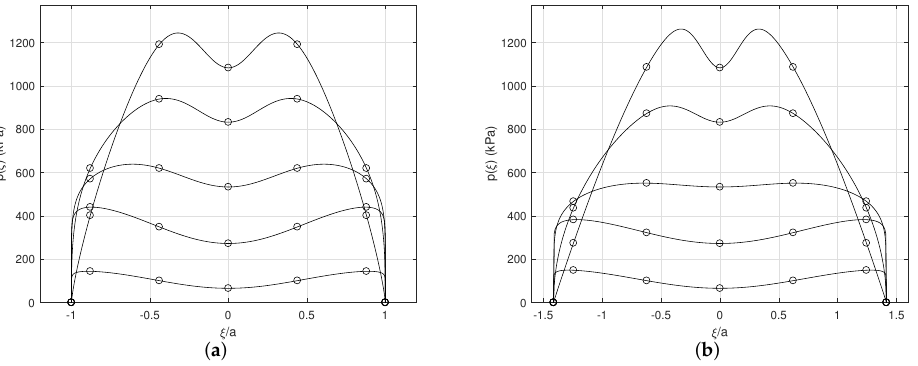
Figure 1. Data from five loading cases in the experiment of Murzenko [3]: ( a ) taken from pressure cells across the center of a square footing of width 2a; ( b ) across the 45 ◦ diagonal. The data are curve-fit using Equation